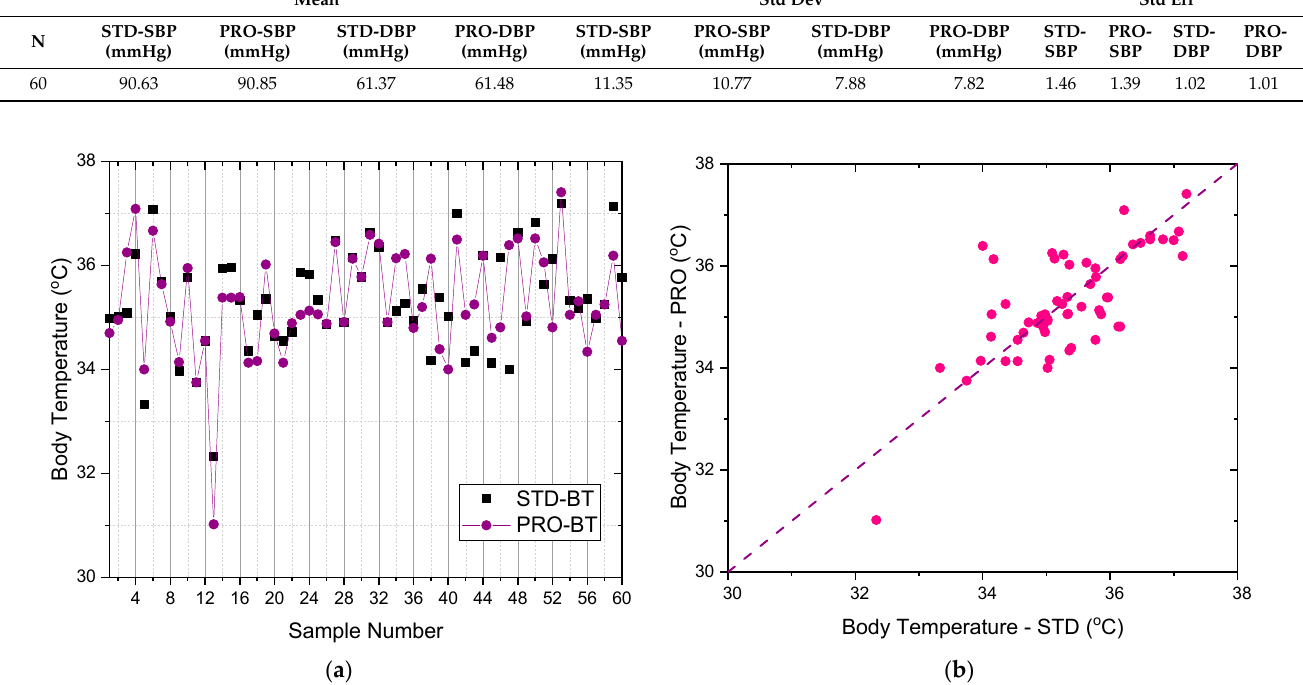
Figure 11. The comparison of body temperature results between the proposed smart devices (PRO) and the standard